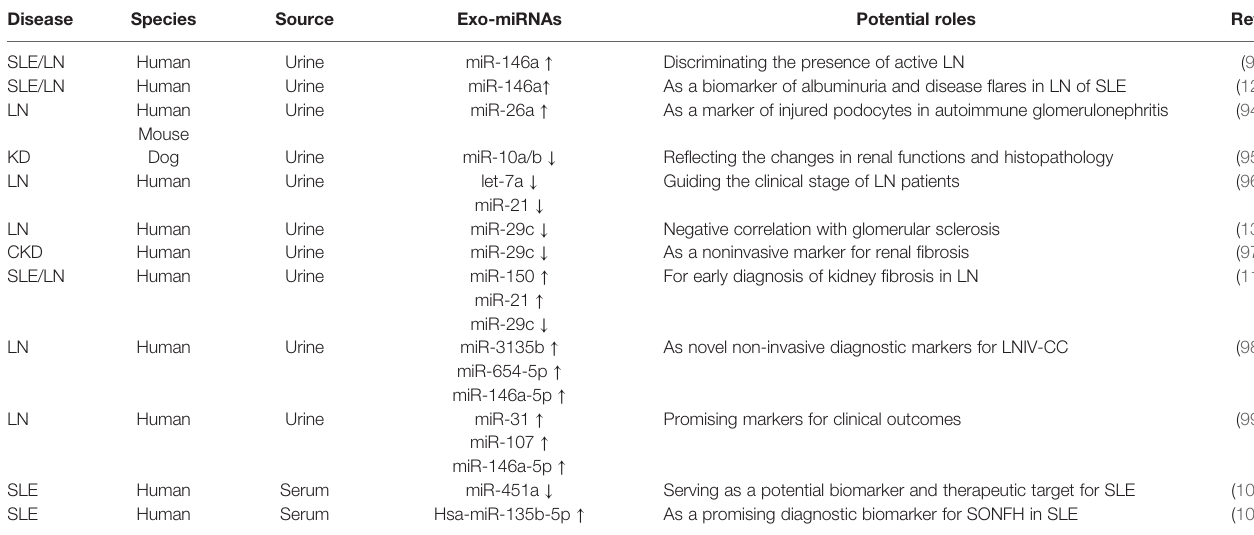
TABLE 2 | Altered expression and potential roles of exosomal miRNAs in renal damage. Disease